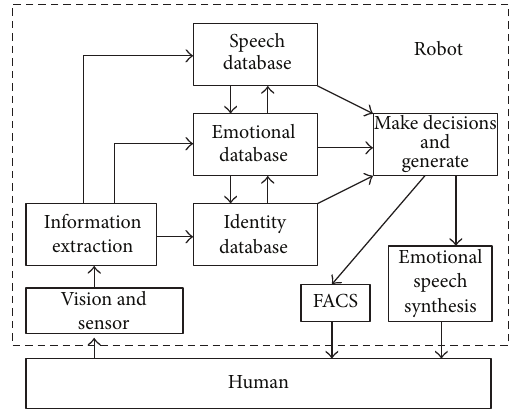
Figure 2: Robot head control system.